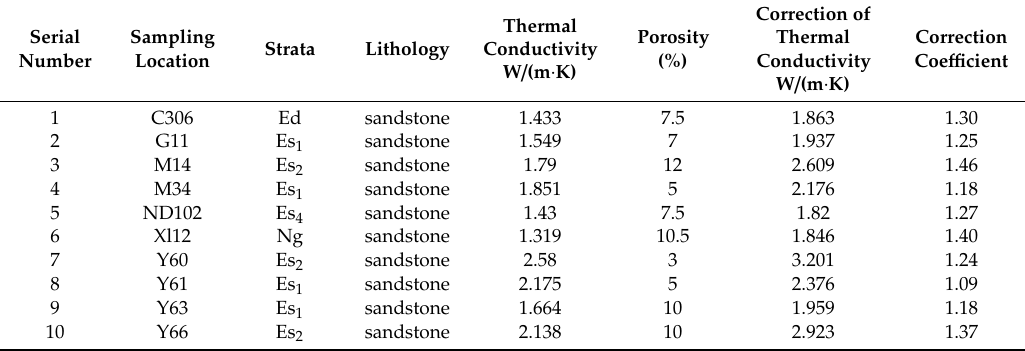
Table 1. Calibration table of the thermal conductivity of Cenozoic sandstone